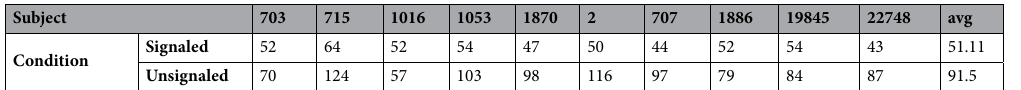
Table 1. Cumulative obtained food over the last five sessions of training in the signaled and unsignaled conditions on free choice trials as a function of